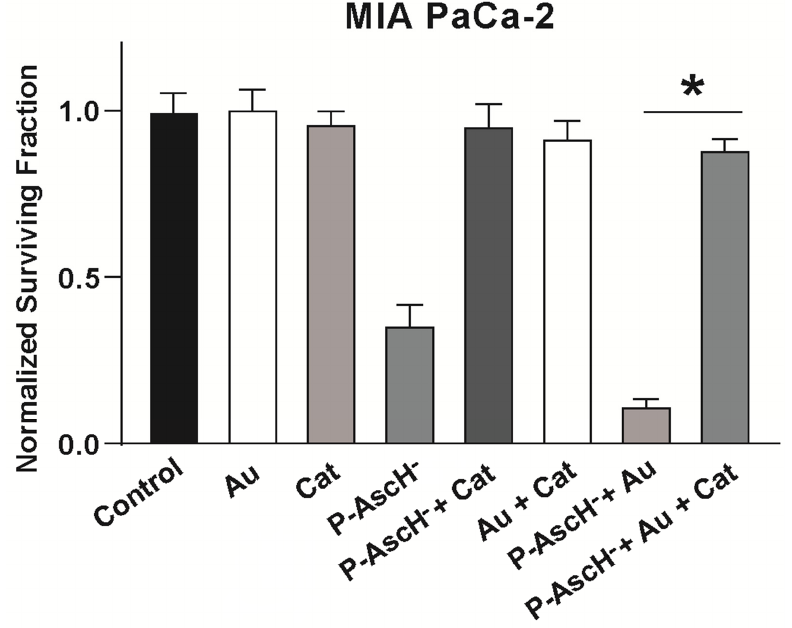
Figure 5. Catalase reverses killing induced by the combination of Au and P-AscH − . MIA PaCa-2 cells were evaluated for clonogenic cell survival after treatment with either catalase (Cat, 100 U/mL, 1 h), Au (500 nM, 24 h), and/or P-AscH − (1 mM, 1 h). The combination of P-AscH − and Au significantly decreased clonogenic cell survival compared to P-AscH − , and the addition of catalase completely reversed the decrease. Data represent normalized surviving fractions compared to controls ± SE (* p < 0.05; one-way ANOVA with Tukey’s multiple comparisons). Reprinted/adapted with permission from Ref. 102. 2017, O’Leary, Elsevier. [102,103].